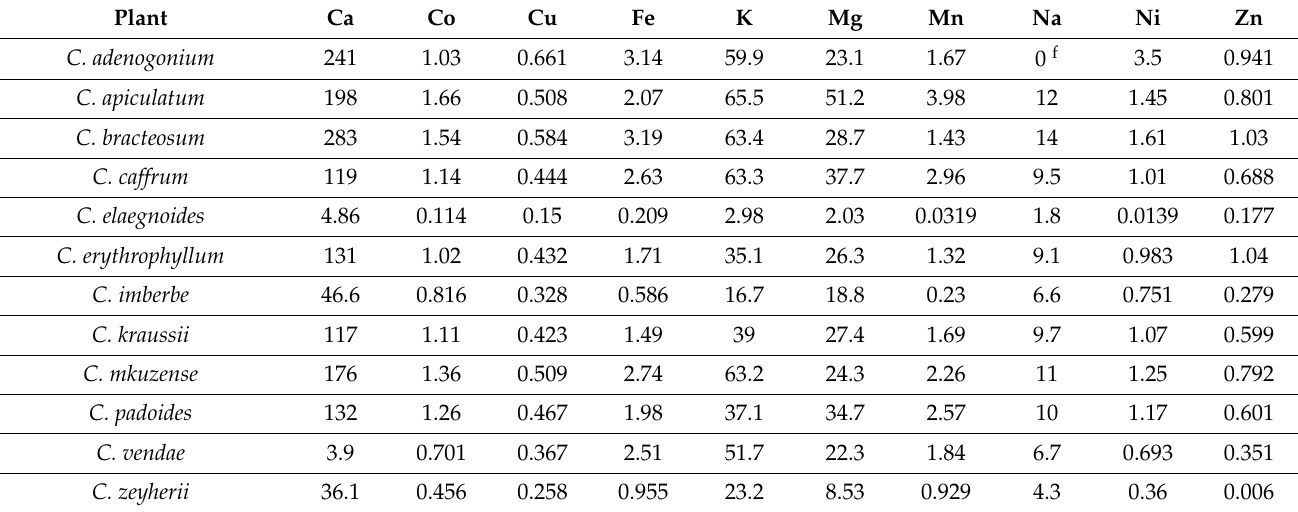
Table 5. Concentration (mg/mL) of trace minerals in the leaves of some Combretum species. Plant